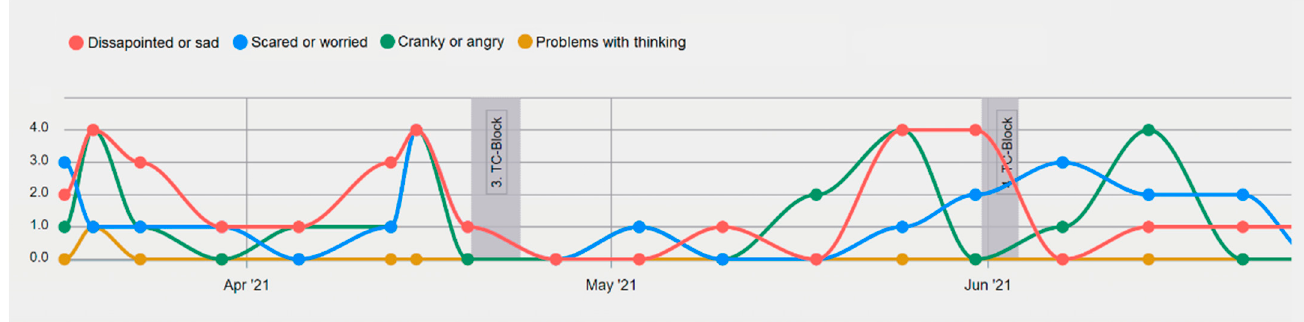
Figure 2. MyPal Symptom Trajectory. Example of symptoms reported by a patient undergoing chemotherapy treatment with topotecan/cyclophosphamide (TC-Block). This patient tended to show increased emotional distress symptoms prior to an upcoming chemotherapy block. Symptoms are graded according to their severity (not present to extremely strong).